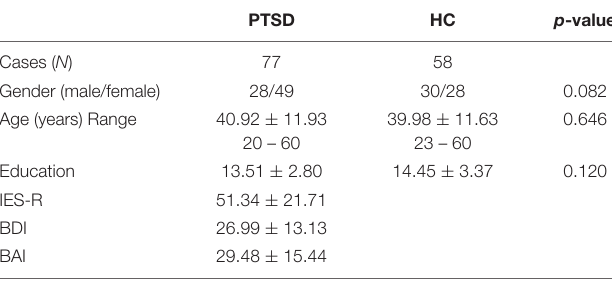
TABLE 1 | Demographic data of post-traumatic stress disorder (PTSD) patients and healthy controls (HC). The p- values represent significant differences between the two